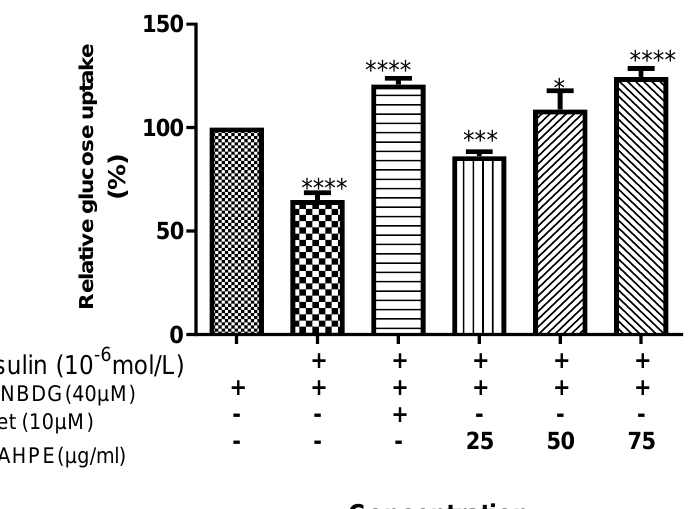
Figure 4. Effect of AAHPE on insulin-stimulated glucose uptake in insulin-resistant HepG2 cells. The insulin-resistant cells induced with 10 −6 mol/L insulin were treated with AAHPE (25–75 µg/mL) concentrations or metformin for 48 h and glucose uptake was measured using fluorescent D-glucose 2-NBDG. Values are mean ± SD, * p < 0.05, *** p < 0.001 and **** p < 0.0001 significant compared with the control.